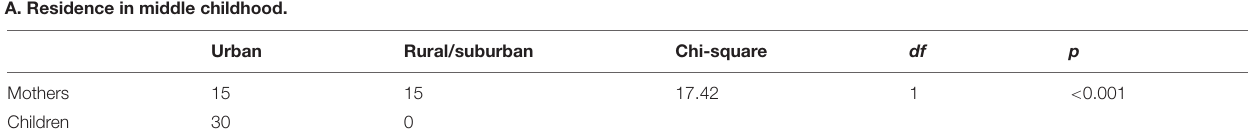
TABLE 2 | Intergenerational differences in